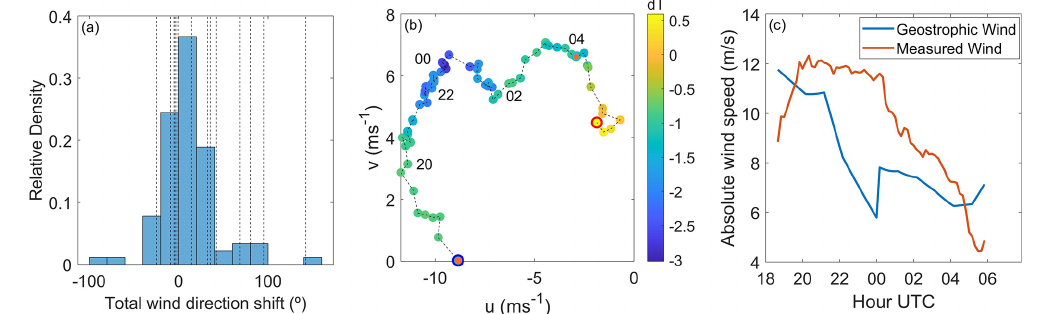
Figure 12. Directional shifts during NLLJ development. Shown are (a) frequency of the total wind direction shift in the NLLJ cores for Lindenberg, (b) the zonal ( u ) and meridional ( v ) wind components during the NLLJ in the night of 12–13 August 2020 in Falkenberg, and (c) the actual and geostrophic wind speed. In (a) positive values mean a clockwise shift, and dashed lines mark the total directional shift during the very long NLLJs. In (b) the color illustrates the vertical temperature change ( dT ) in the first 10ma.g.l., and the blue (red) circle marks the start (end) of the NLLJ. The additional orange circles mark the sunset and sunrise, and the numbers are the UTC times. The geostrophic wind in (c) was calculated from ERA5 data (Hersbach et al., 2020) and interpolated to the measurement